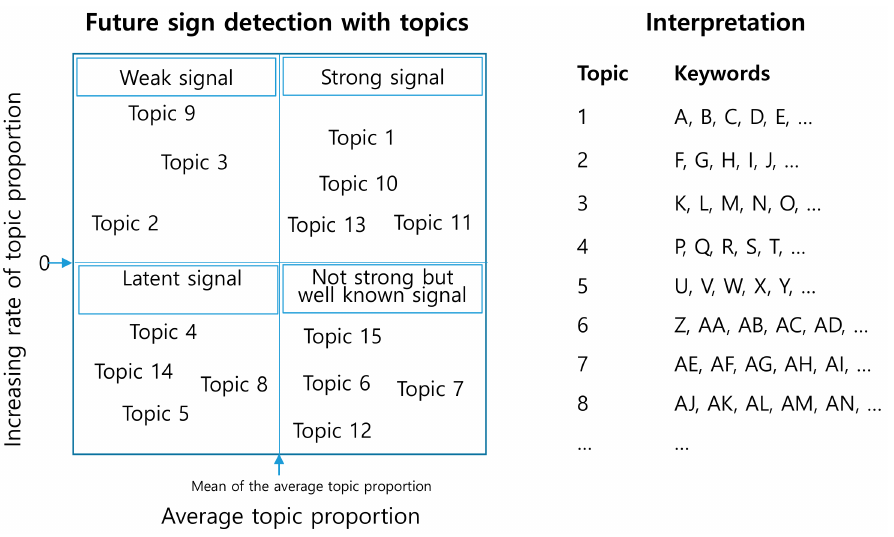
Figure 2. New process identifying future signs by using structural topic modeling